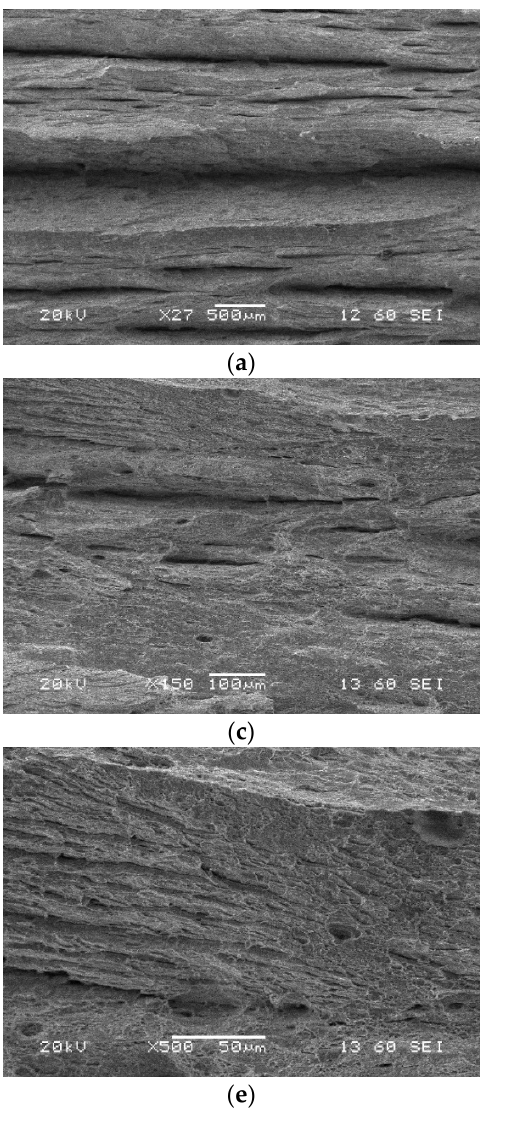
Figure 17. Microstructures of the crack propagation zone of the parent material (specimen No. 7) captured after CTOD test using SEM; magnifications: ( a ) × 27; ( b ) × 50; ( c ) × 450; ( d ) and ( e ) × 500; ( f ) × 1000.